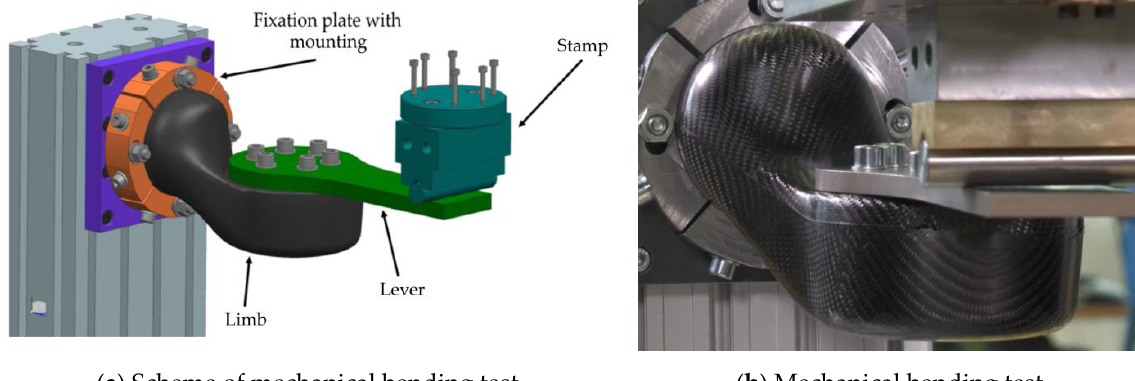
Figure 10. Illustration of the structural limb bending test.